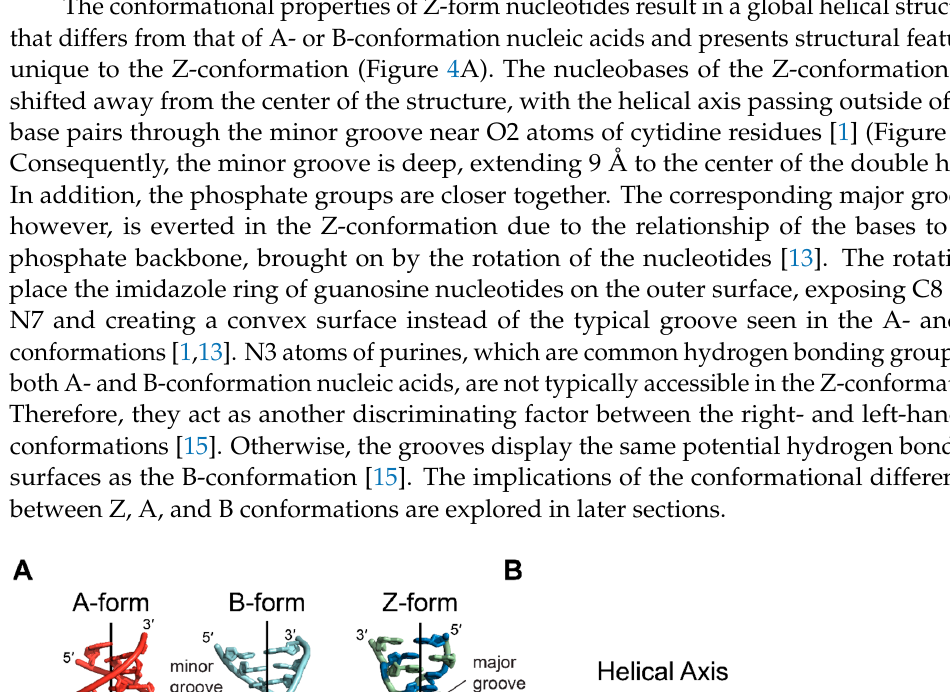
Figure 4. Comparison of helical axes between A-, B-, and Z-form nucleic acids. ( A ) Side ( top ) and top-down ( bottom ) views of A-form (red, PDB: 413D [48]), B-form (cyan, PDB: 6CQ3), and Z-form (green and blue, PDB: 4OCB [49]) nucleic acids. Position of helical axes are drawn as a line for each